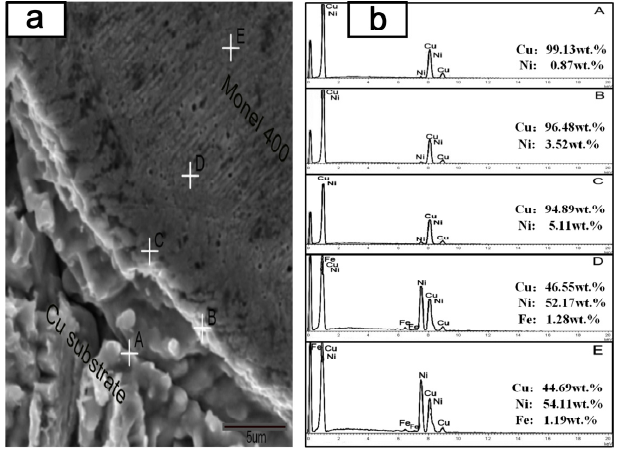
Figure 8. Interface zone of Cu substrate and Monel400 transition layer and EDS results of different areas.